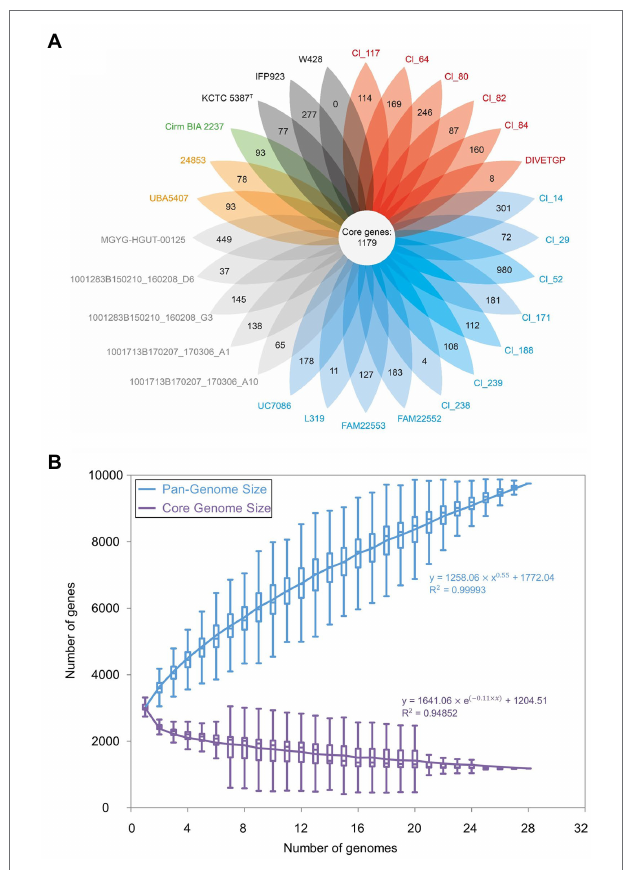
FIGURE 3 | Genomic diversity of 28 Clostridium tyrobutyricum strains. (A) Core and strain-specific genes of 28 C. tyrobutyricum genomes. Each oval represents a strain. The number of genes shared by all strains (core genome) is in the center. The number of strain-specific genes is indicated in non-overlapping portions of each oval. The type strain is indicated by the superscript capital T. (B) Increase and decrease in gene families in the pan- (blue) and core (violet) genome, respectively. Gene accumulation curves were plotted as a function of the number of genomes sequentially added ( n = 28) of the power-law regression model. The pangenome size is calculated at 9,748 genes. The trajectory of the pangenome shows characteristics of an open